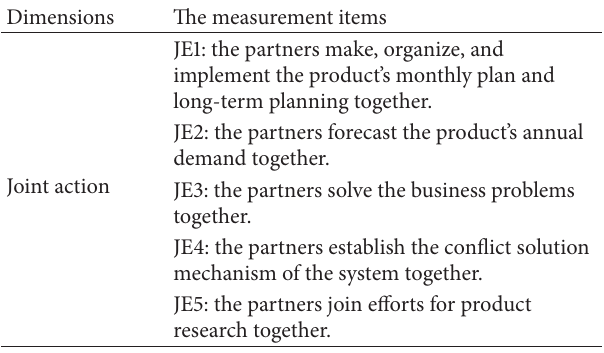
Table 6: The specific indexes of specific asset investment. Dimensions The measurement items